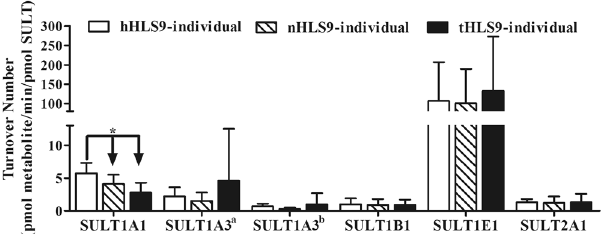
Figure 7. TONs of the probe substrates metabolized by SULT enzymes in healthy donors, HCC tumors, and match pericarcinomatous tissues, thereby, indicating the catalytic efficiency of enzymes. There is one concentration of probe substrate activities for each SULT, as follow: 1 μ M p-nitrophenol for SULT1A1, 0.625 μ M dopamine for SULT1A3, 2.5 μ M 2-aminophenol for SULT1B1, 10 μ M 17 β -estradiol for SULT1E1, and 1 μ M DHEA for SULT2A1. It is defined as the number of substrate molecules that can be converted by enzyme proteins into products per unit of time. Paired sample t -test or Wilcoxon’s sign rank test was used for data analysis. “ * ”Denotes statistical significance ( P < 0.05).